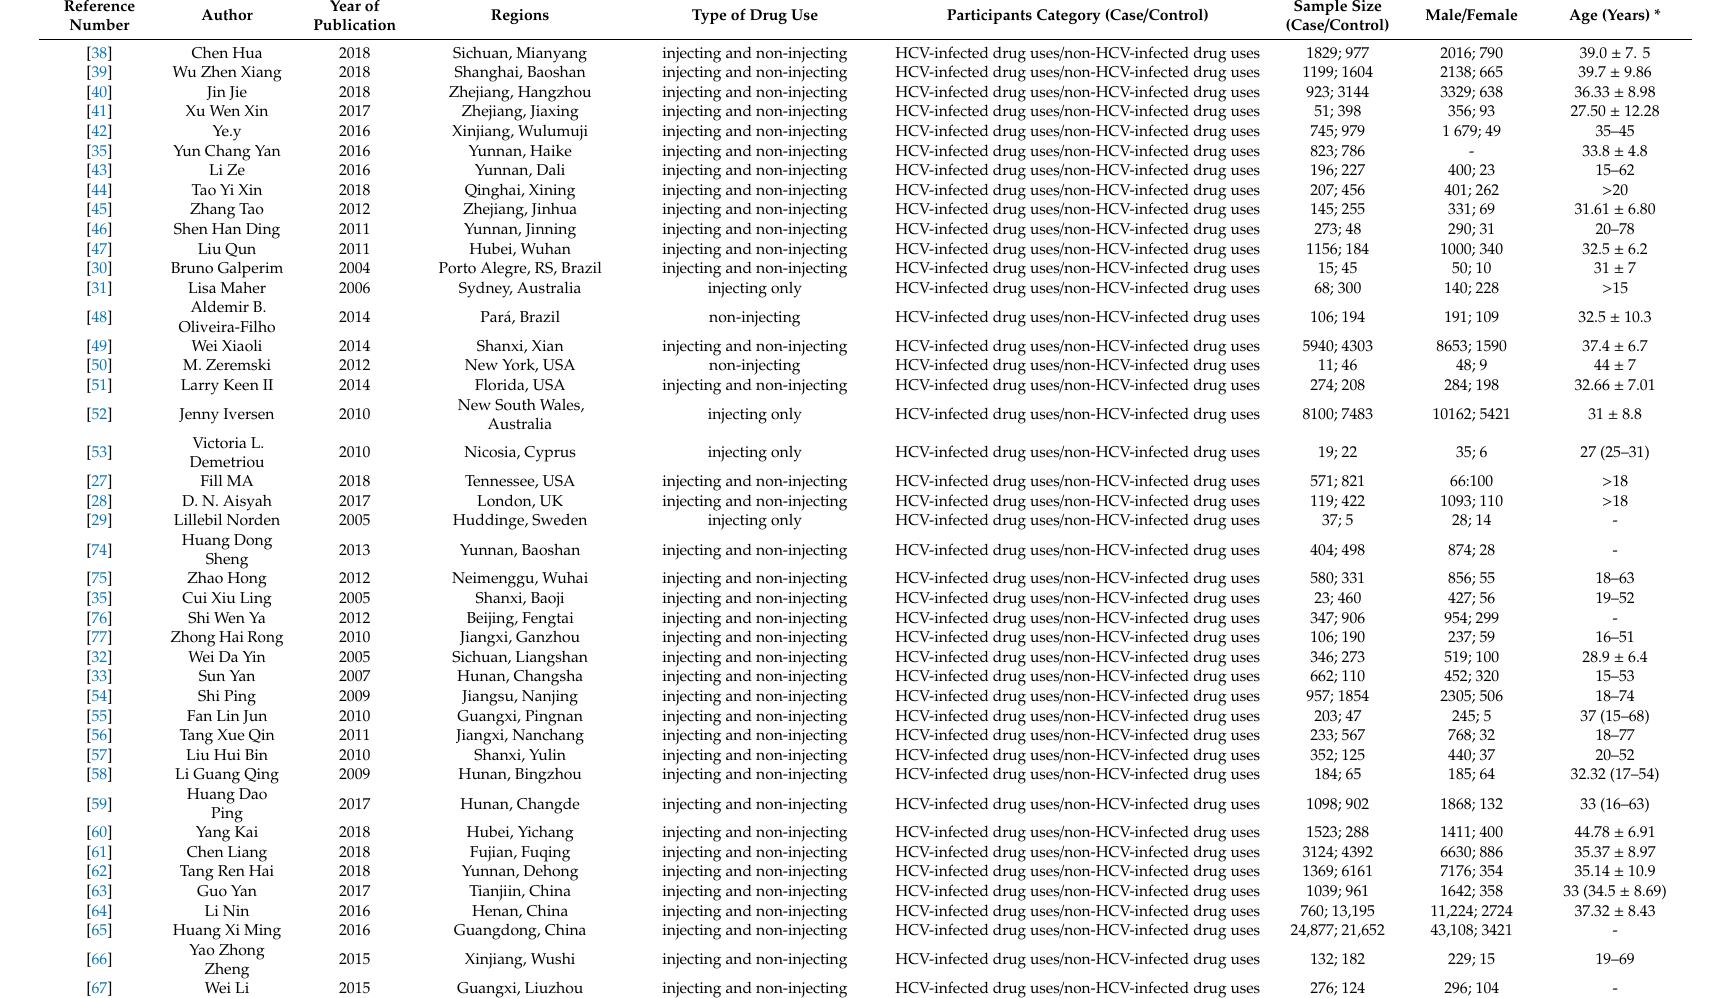
Table 1. Characteristics of the